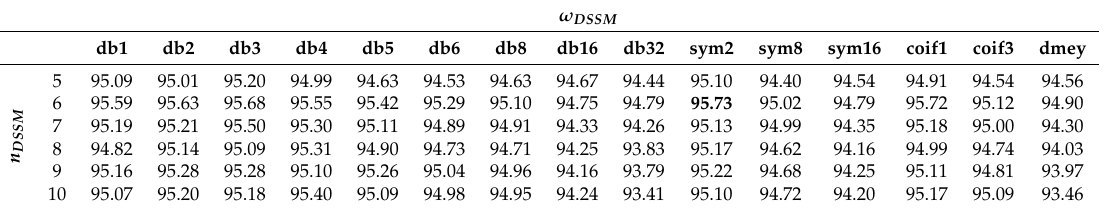
Table 11. The accuracy (%) of two class sleep stage classification with different wavelet bases and different order of DSSM under AASM standard. Only DSSMFs are used, no LEFs.